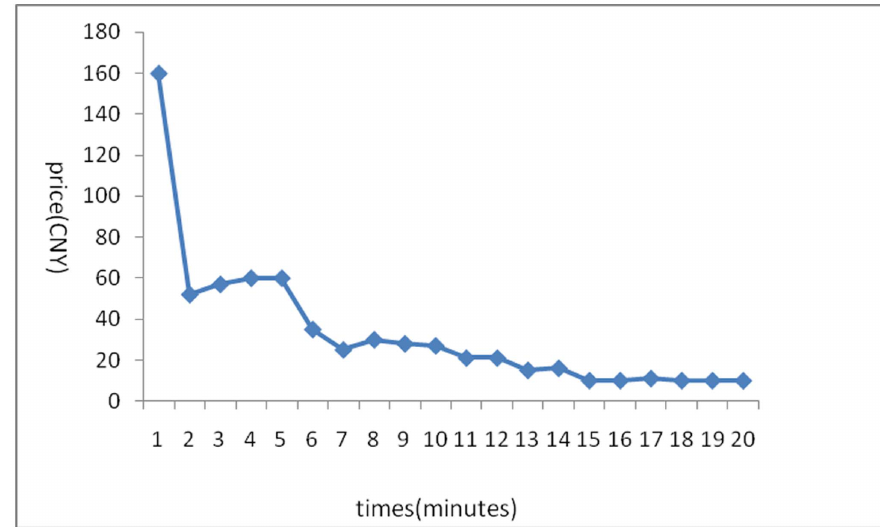
Figure 6. Third Experiment of a Unilaterally Price-Falling Situation with Manipulation.